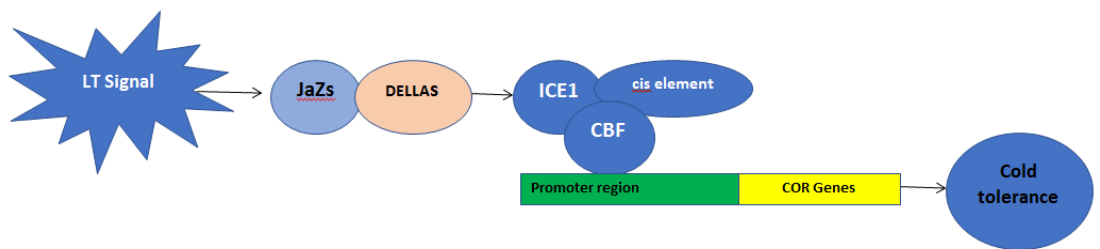
Figure 1. ICE-CBF-COR pathways in plants tolerance to cold stress. The expression of CBFs is mainly mediated by DELLA signaling and induced by ICE1 . DELLAs contribute to the cold induction of CBF genes through interaction with JaZs signaling. CBFs activate the expression of COR genes via binding to cis-elements in the promoter of COR genes and result in the enhancement of cold tolerance in plants. In temperate plants of wheat and barley, CBFs are found in the Frost Resistance 2 (FR2) locus [4]. Winter barleys planted in early autumn need collaboration between Vernalization 1( VRN1 ) and CBF genes to enhance cold acclimation. However, for spring barley, vernalization is not required. As a result, spring barley is not freezing tolerant. Similar to spring barley, 214 upregulated genes and 884 downregulated genes were found in grapevine cultivars after LT treatment [25], suggesting that cold stress induced the downregulated genes. This study found that CBF1 , CBF2 , and CBF3 had no role in cold acclimation in grapevine leaves. This is due to the absence of CBF1 and low levels of CBF2 and CBF3 . However, there were some exceptional cases in the mechanisms of the CBF gene family expression. A study found that ICE1 mutation only had a small e ff ect on the CBF transcript [21]. The expression of CBF1 is also regulated by the SVALKA-CBF1 cascade. SVALKA is a long